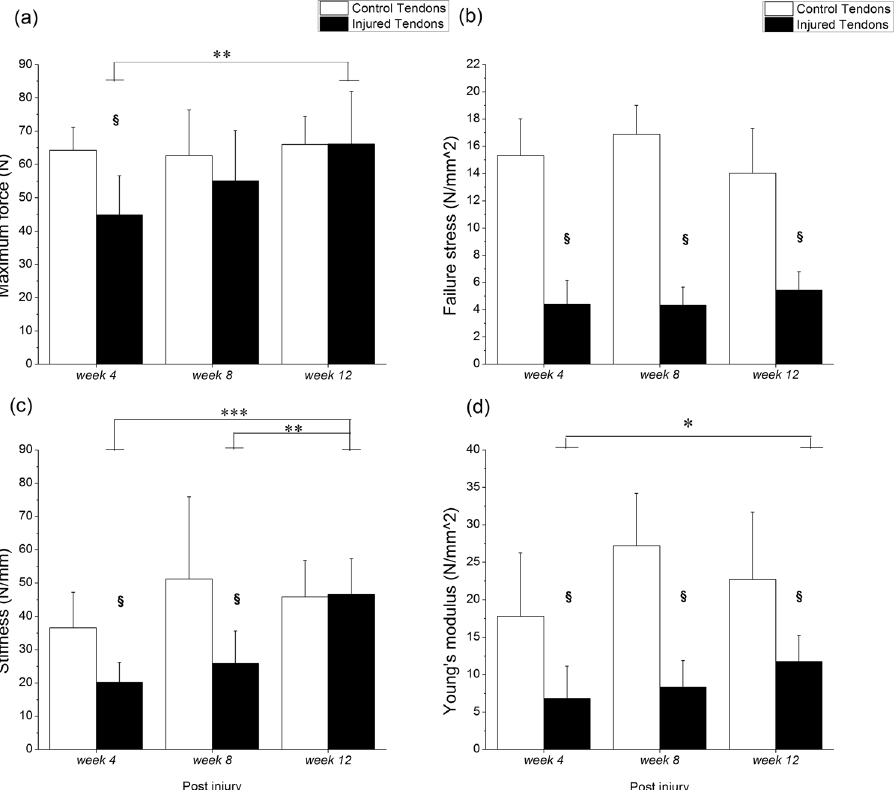
Figure 2. Biomechanical properties of Achilles tendons. ( a ) Maximum force, ( b ) failure stress, ( c ) stiffness, ( d ) Young’s modulus are shown after week 4 , week 8 , and week 12 . § Compared with the control